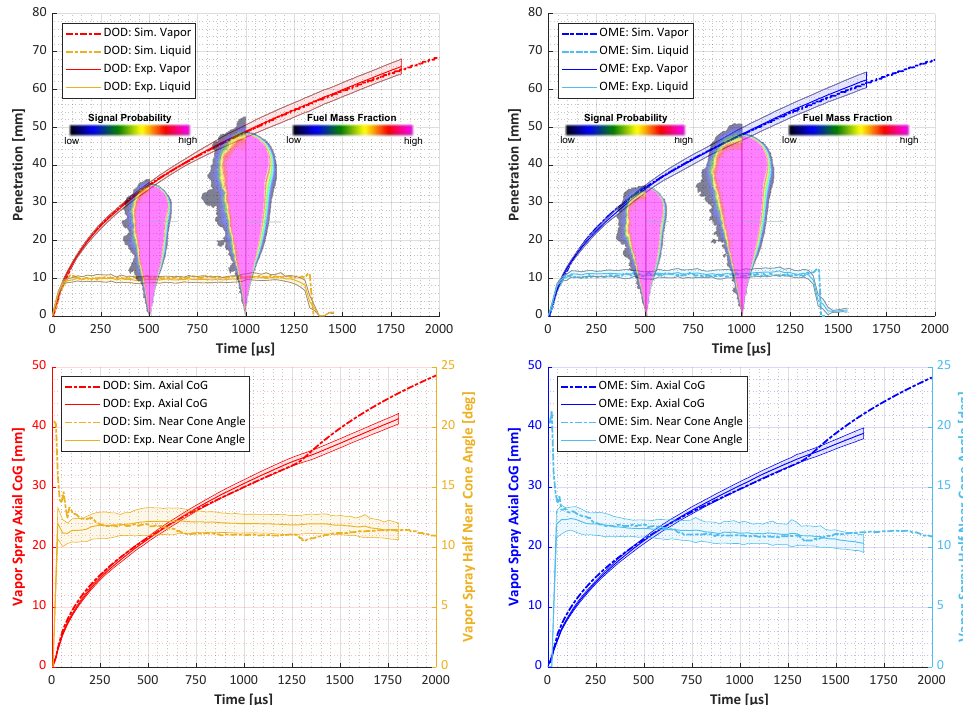
Figure 4. Conti3L: Spray penetration ( top , projected liquid volume and vapor) and vapor dispersion ( bottom , half near cone spreading angle and axial center of gravity) for inert chamber conditions ( Ai : T CC = 900 K, ρ CC = 22.8 kg/m 3 and 0% O 2 ) : ( left ) Dodecane. ( right )